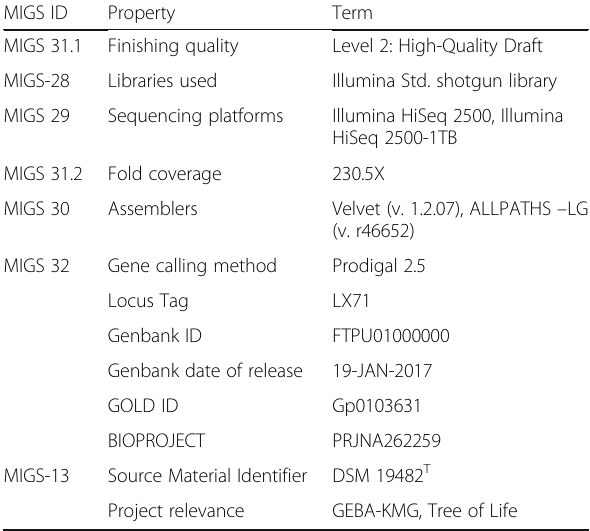
Table 2 Genome sequencing project